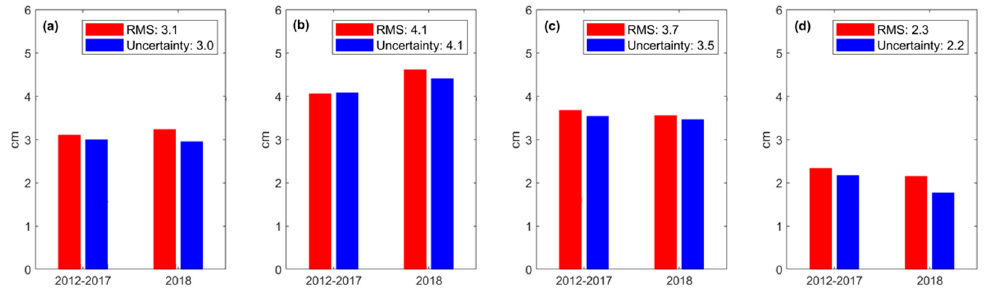
Figure 10. RMS statistics of the SHAtropE ZTD RMS w.r.t. RAW ZTD, and the predicted ZTD uncertainty of the model during 2012–2017 (red) and 2018 (blue) in different seasons: ( a ) Mar-Apr-May, ( b ) Jun-Jul-Aug, ( c ) Sep-Oct-Nov, and ( d ) Dec-Jan-Feb. The average values of the whole period 2012-2018 are presented in the legend.